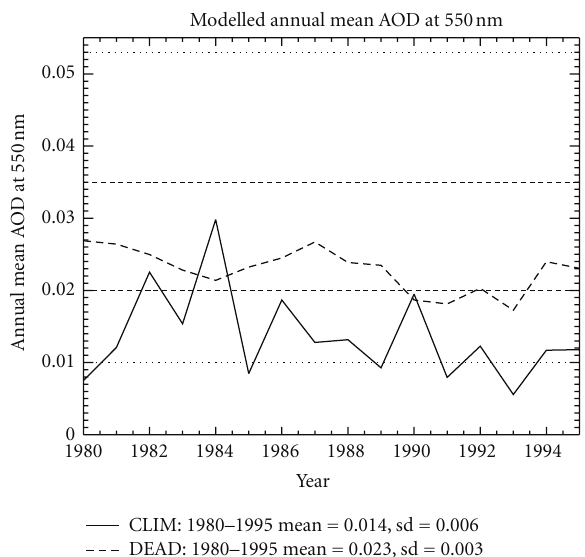
Figure 2: Time series of global, annual mean AOD (550 nm) for the simulations with the CLIM (solid) and DEAD (dashed) dust uplift schemes. The full and “80% of models” ranges estimated by [34] are given by the dotted and dashed lines,